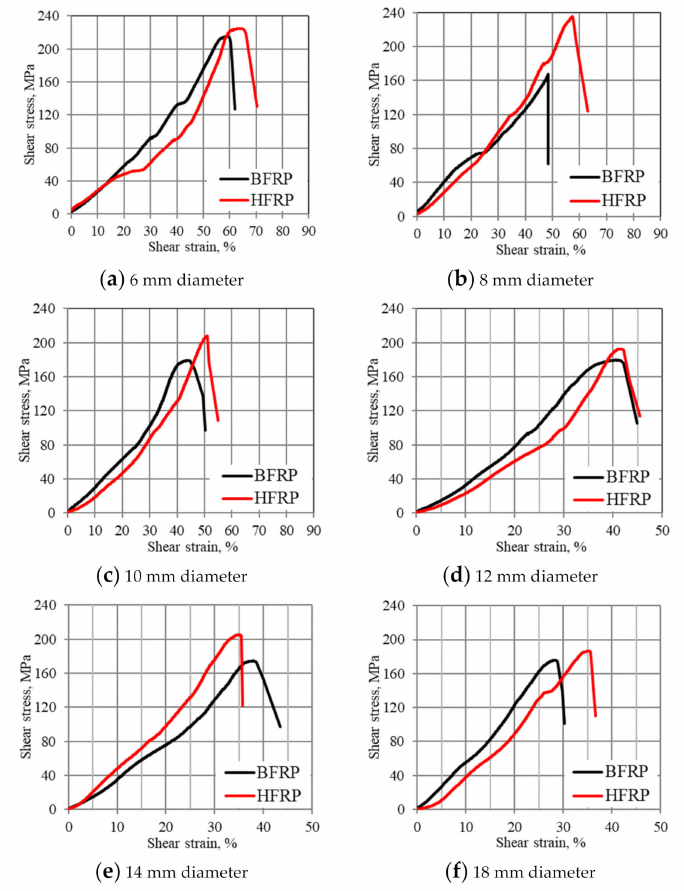
Figure 7. Shear stress–strain relationship of FRP bars tested with means. ( a ) Ø6, ( b ) Ø8, ( c ) Ø10, ( d ) Ø12, ( e ) Ø14, ( f ) Ø18